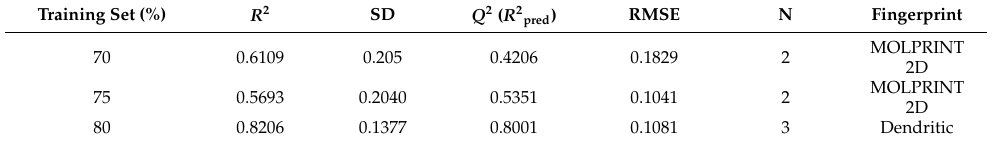
Table 2. Statistically significant models generated by AutoQSAR for the G 1 group.